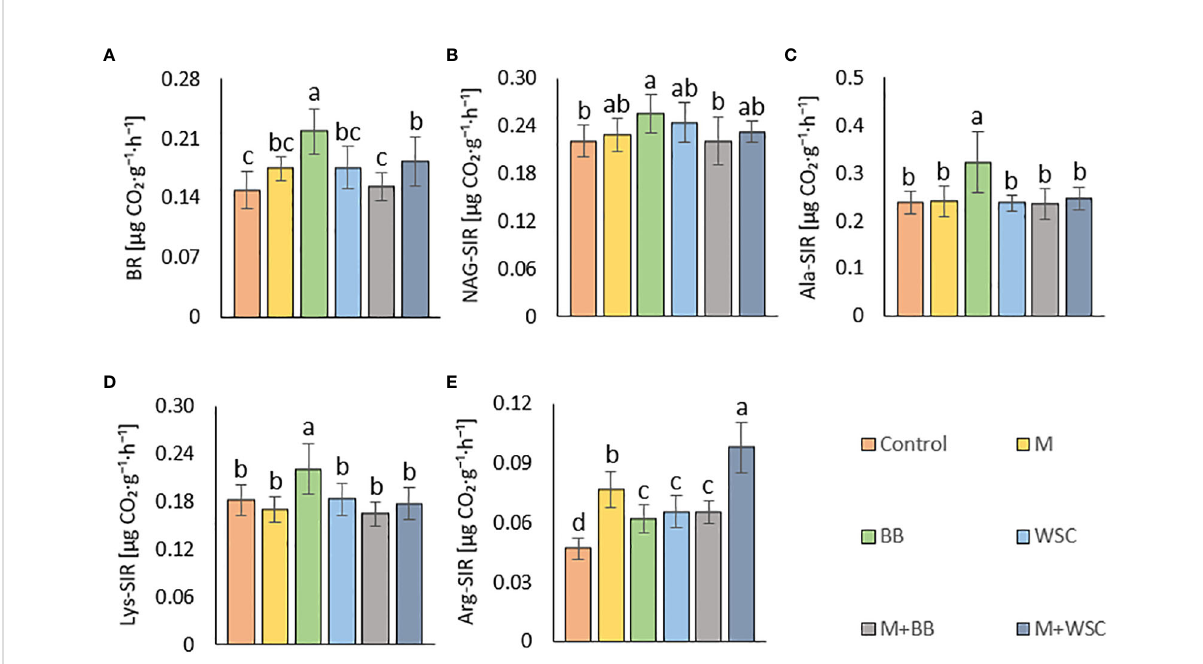
FIGURE 5 (A) Soil basal, BR and substrate-induced respirations - (B) N-acetyl- b -D-glucosamine, NAG-SIR; (C) L-alanine, Ala-SIR; (D) L-lysine, Lys-SIR; and (E) L-arginine, Arg-SIR; of the control (no digestate) and all variants amended with digestates made from single crop and mixed cultures, n=12. Mean ± standard error of mean (error bars); different letters indicate statistically signi fi cant differences at the signi fi cance level p ≤